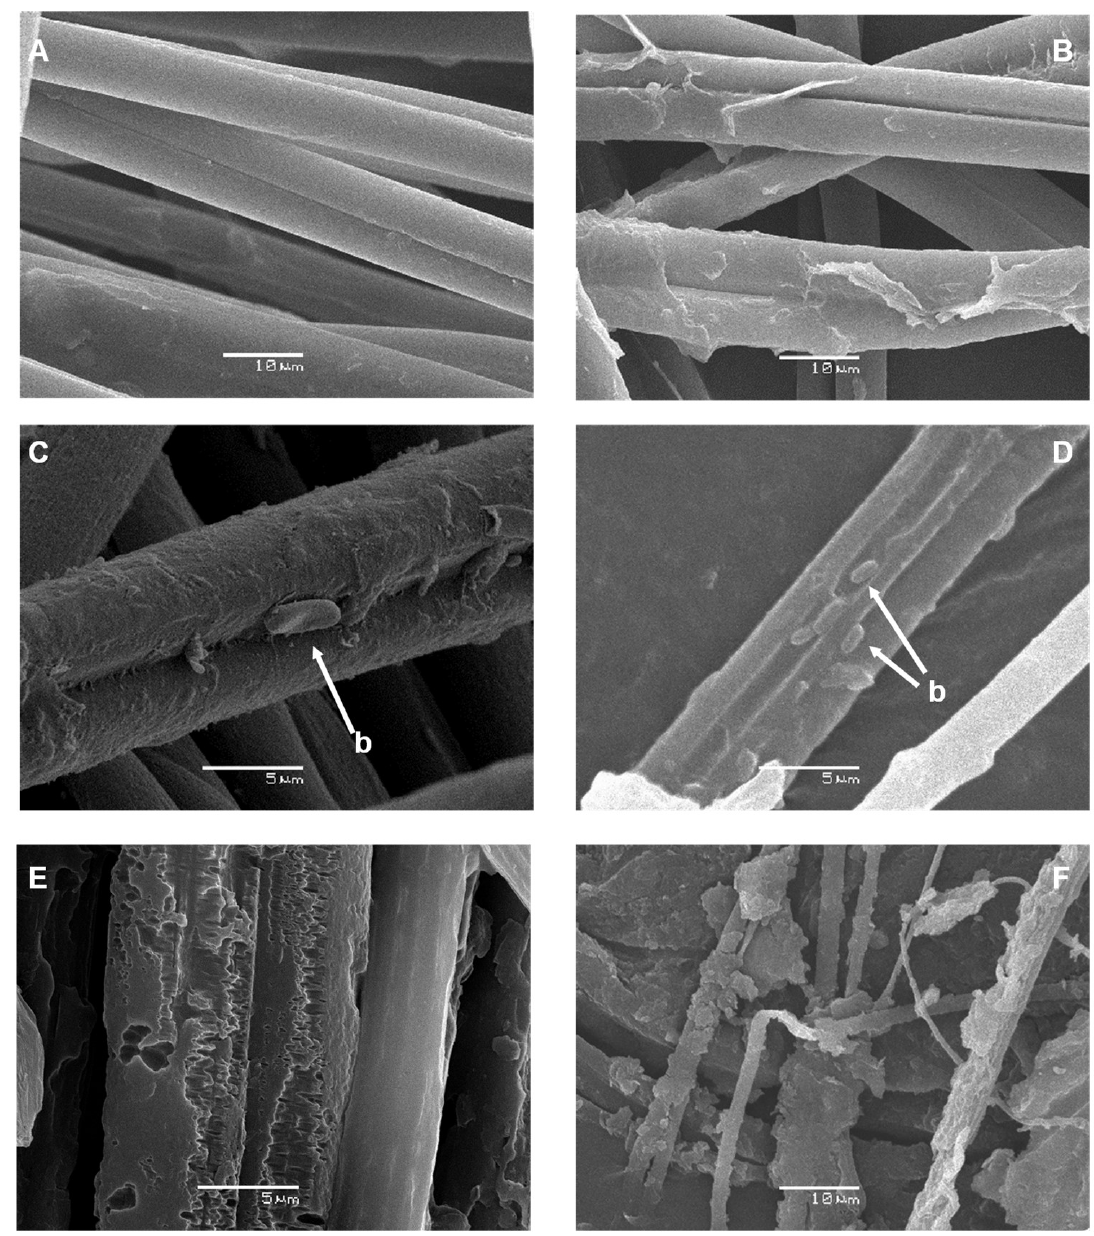
Figure 3. Scanning electron microscopy (SEM) visualization of raw pine processionary silk filaments and their successive degradation over time mediated by a liquid culture of B. licheniformis . Silk native structure at 0 h of incubation ( × 2000) ( A ); partial removal of the sericin surface layer observed at 24 h of incubation ( × 2000) ( B ); almost complete elimination of the sericin layer detected at 36 h of incubation and presence of some bacterial cells (b, indicated by arrows) attached to the underlying fibroin fibers ( × 5000) ( C ) ( × 3000) ( D ); extensive degradation with loss of fibroin fiber structure observed after 48 h of incubation ( × 5000, ( E )) ( × 2000, ( F )).